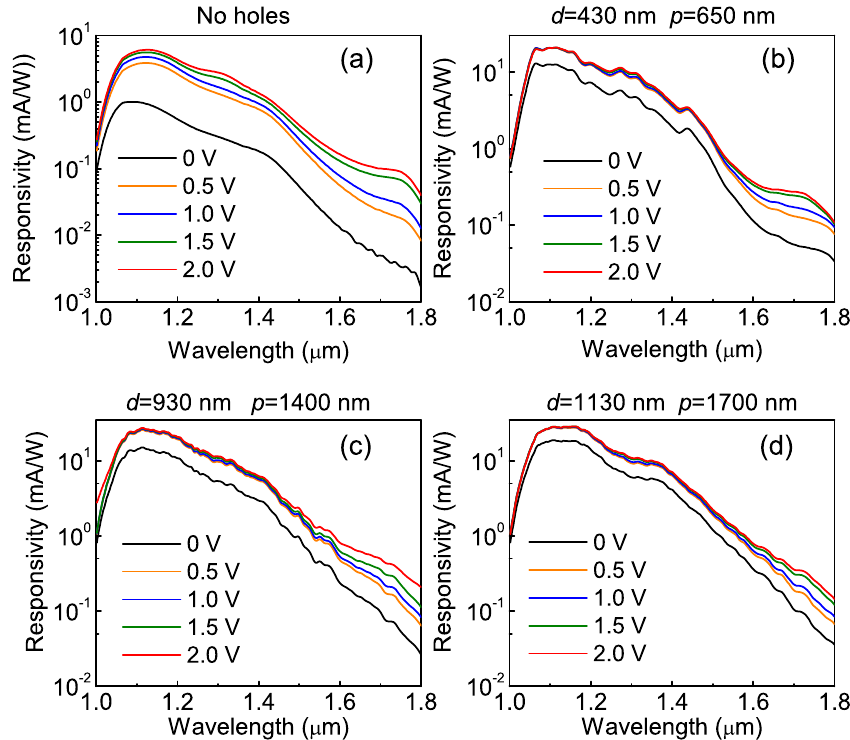
Figure 4. Responsivity spectra of the Ge/Si QDIPs ( a ) without and ( b – d ) with photon-trapping hole arrays. The hole diameter/period values are ( b ) 430/650 nm, ( c ) 930/1400 nm, and ( d ) 1130/1700 nm.